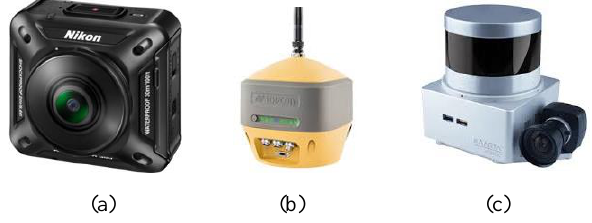
Figure 3. The instruments used in this survey. (a) Camera Nikon Key Mission 360. (b) Hiper Hr receiver by Topcon. (c) Laser Scanner Kaarta Stencil